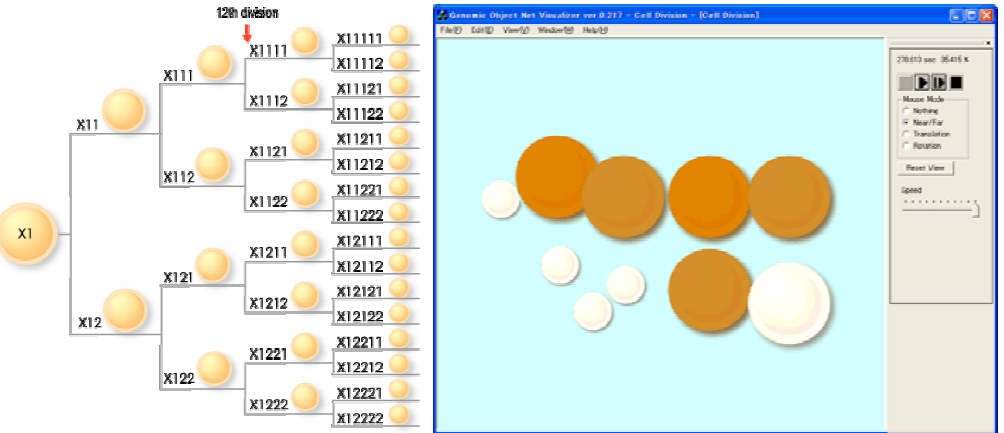
Figure 5. Cell dividing process based on data from simulation. (a) Cell dividing process from the 10th division to the 13th division. At each cell, a name such as X1122 is assigned, which is the name of the cell among eight cells just after the 12th division. Each of 31 CSV files produced from the simulation by GON has the same file name as the cell name. (b) Screenshot of GON Visualizer. The diameter and the color of each cell change according to two series of values for the cell volume and the MPF concentration in the CSV file, respectively. The simulation can be viewed through the web site http://genome.ib.sci.yamaguchi-u.ac.jp/˜f